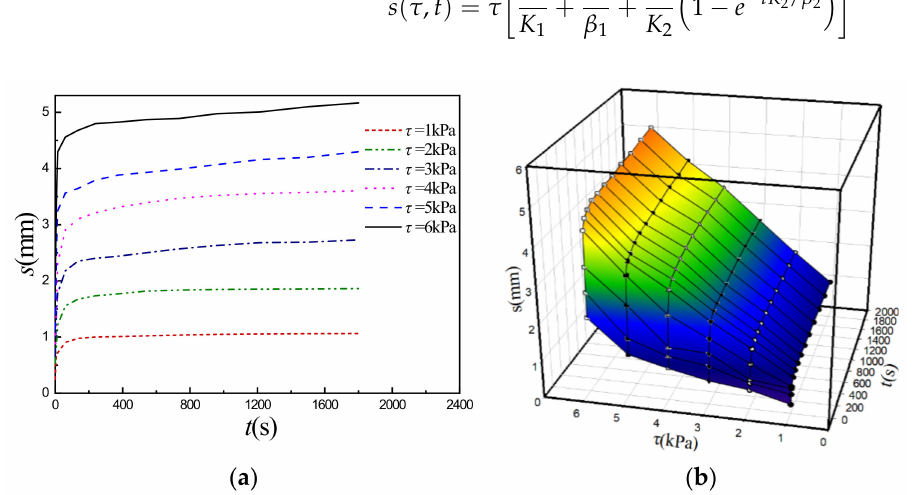
Figure 3. Shear creep curves and fitted 3D surface at σ = 5 kPa. ( a ) Shear creep curves under τ ; ( b ) Fitted curved 3D